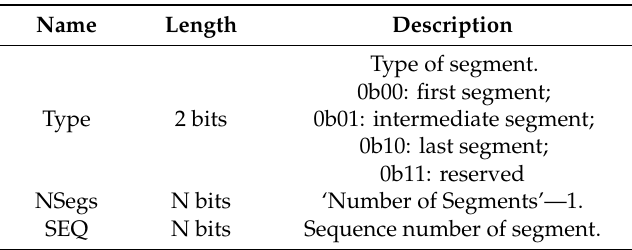
Table 4. Segmentation header fields and